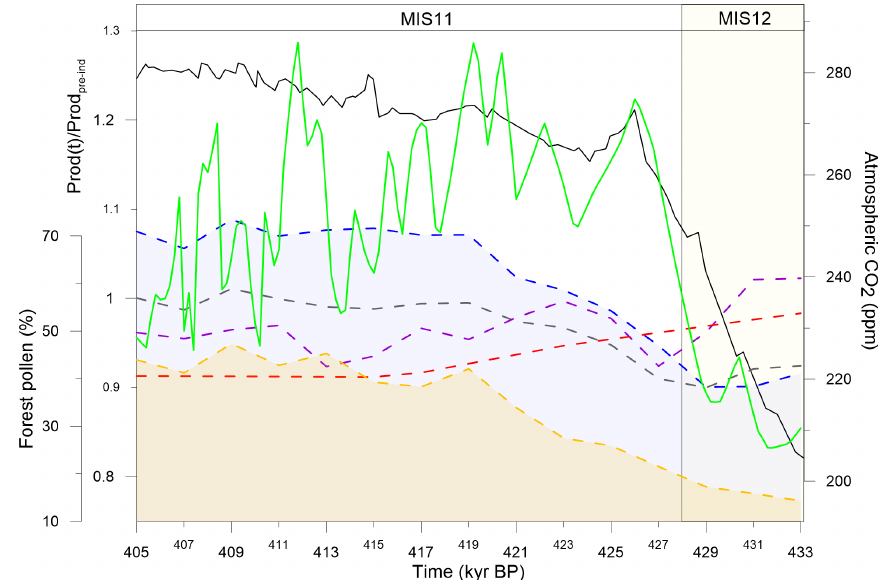
Figure 8. Comparison of forest pollen composites and observed global biosphere productivity (inferred from (cid:49) 17 O of O 2 , solid green line, Brandon et al., 2020) and CO 2 (solid black line, Nehrbass-Ahles et al., 2020) over TV. Forest pollen composites from Fig. 5 are shown in dashed blue (ES-BA), yellow (Subtropical-N), purple (Tropical), red (Subtropical-S) and grey (record average) lines.